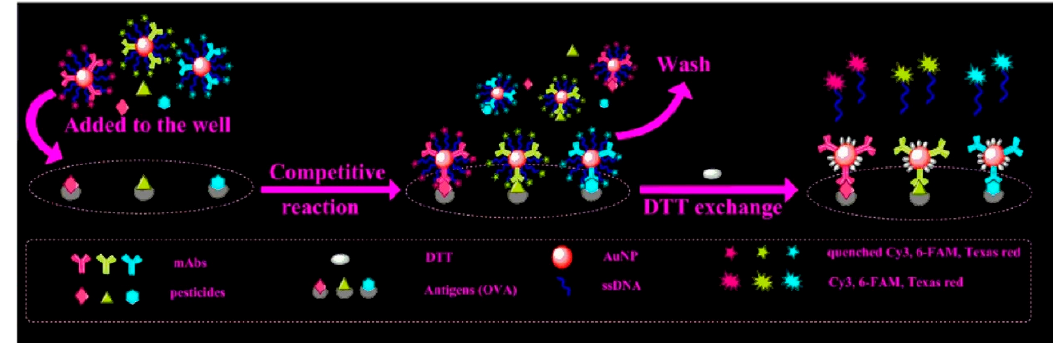
Figure 9. Scheme of the fluorescence immunoassay based on oligonucleotide signal amplification. (Reprinted from reference [123] with permission of Elsevier).